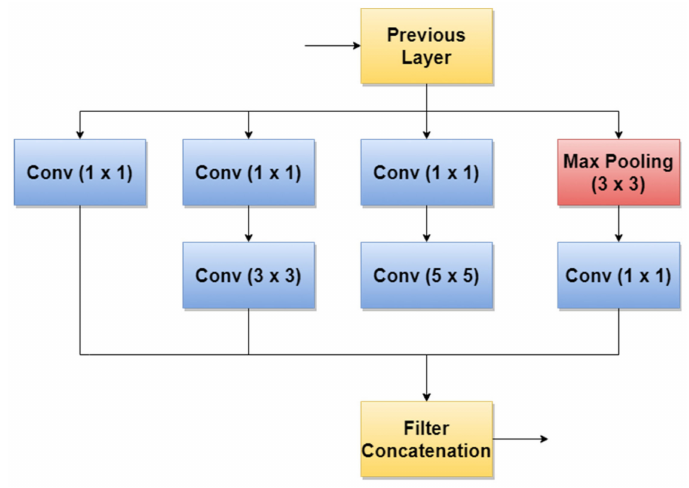
Figure 10. Inception module used in